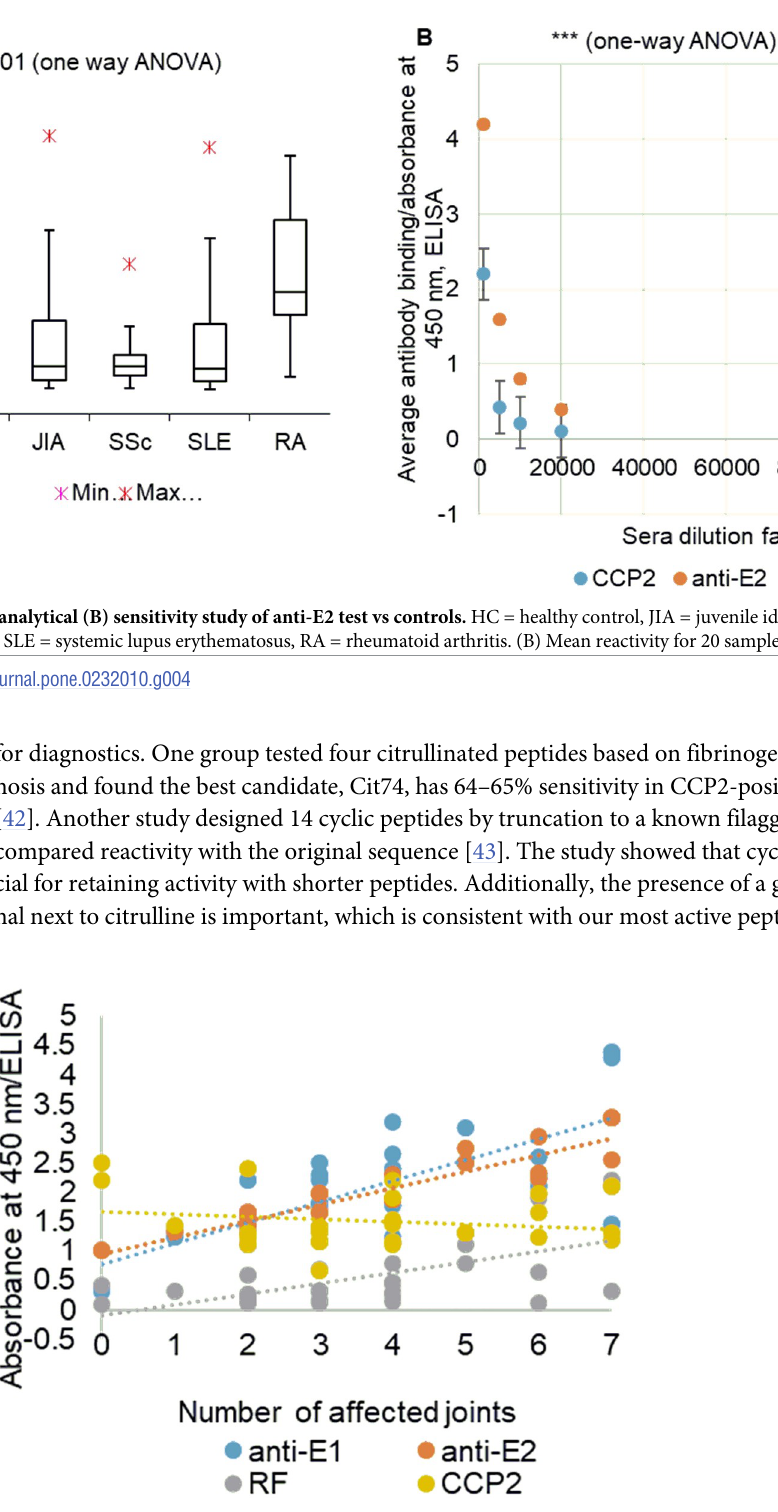
Fig 5. Correlation of anti-E1, anti-E2, ACPA and RF reactivity with number of inflamed joints in RA patients (n = 30; cohort data given in Table 2).